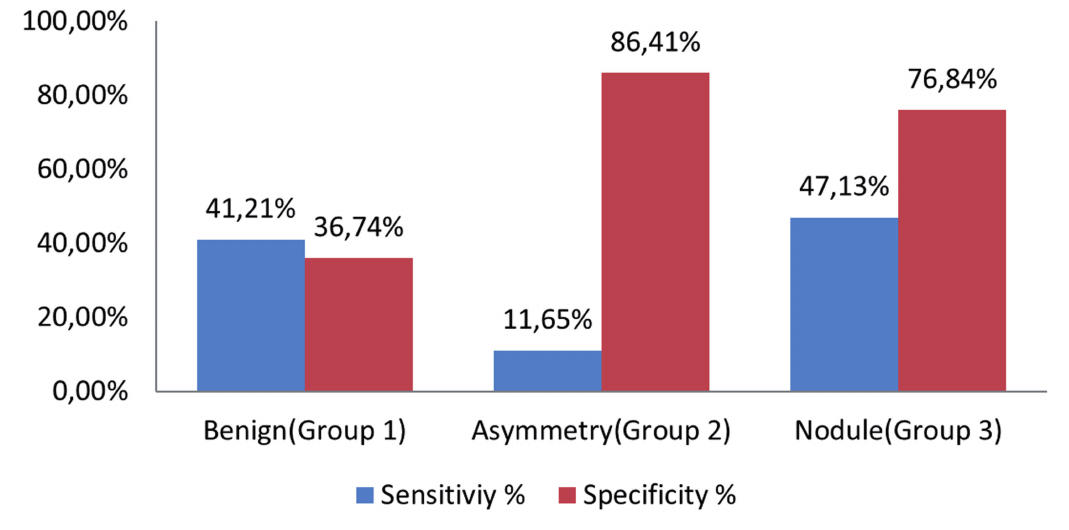
figure 2 - sensitivity and specificity for cancer detection of three